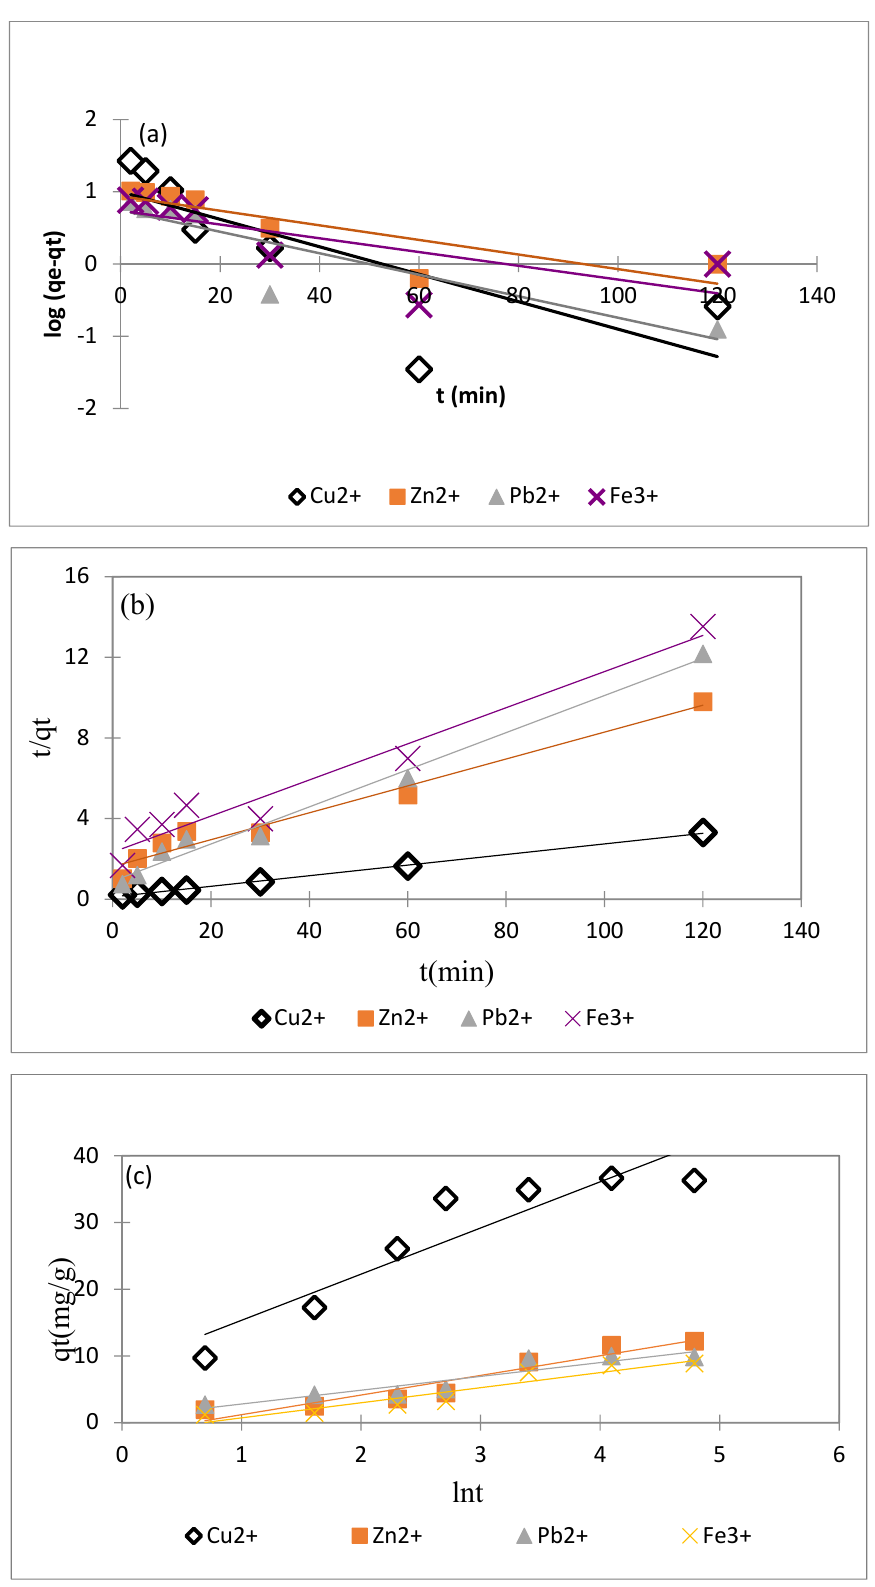
Figure 6. Pseudo-first-order ( a ), and pseudo-second-order ( b ) and Elovich ( c ) kinetics models applied to the adsorption of Cu 2+ , Zn 2+ , Pb 2+ and Fe 3+ onto IIP/Mt nanocomposites.